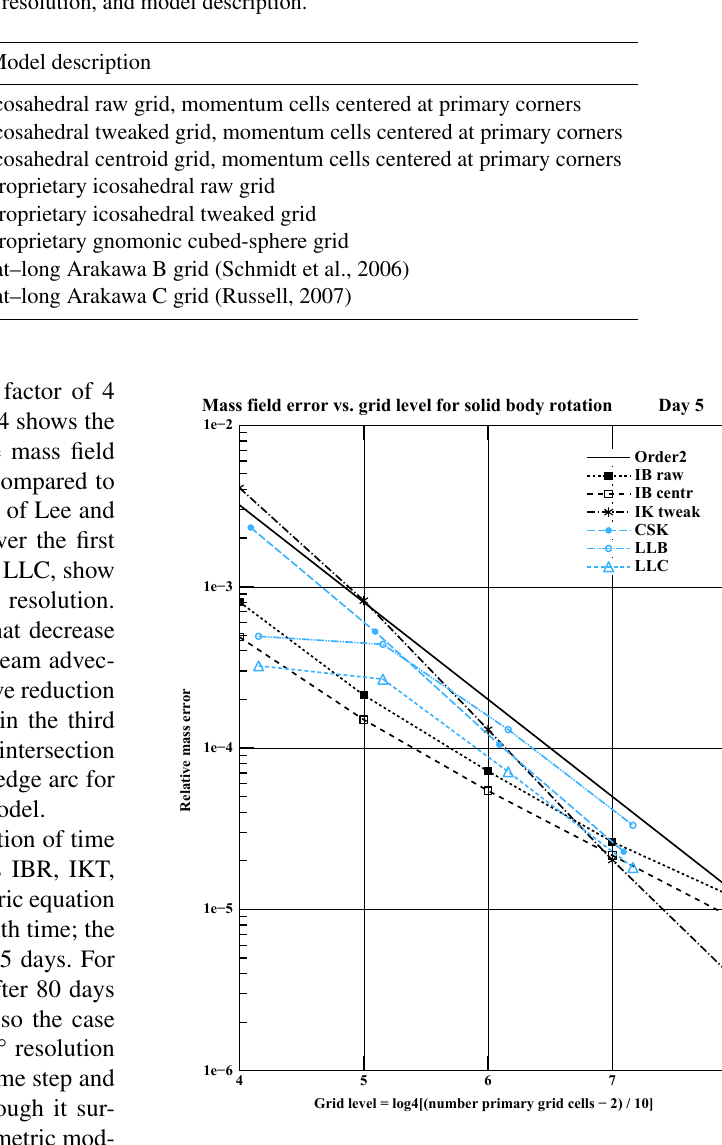
Figure 4. Mass field error l 2 as function of grid level for solid body rotation initial conditions without bottom topography on day 5. Black line shows ideal mass error: factor of 4 error reduction for doubling horizontal resolution. Models represented are IBR, IBC, IKT, CSK, LLB, and LLC. For last three models, grid level is com- puted as log 4 [ (N − 2 )/ 10 ] , where N is the number of primary grid